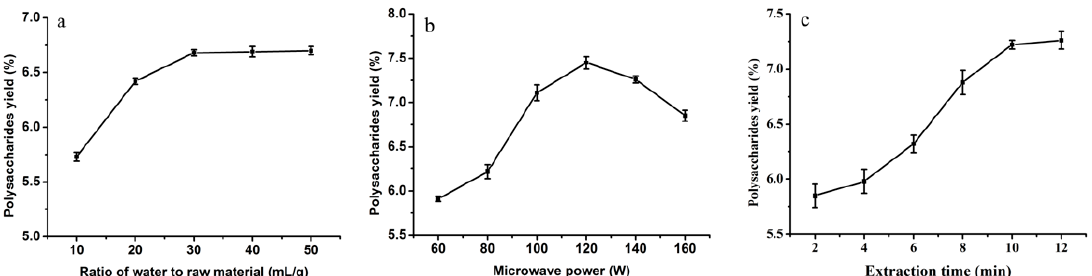
Figure 1. Effects of different extraction parameters (( a ) ratio of water to raw material, mL/g; ( b ) microwave power, W; and ( c ) extraction time, min) on yield of polysaccharides. ( a ) Microwave power and extraction time were fixed at 100 W and 20 min, respectively. ( b ) Ratio of water to raw material and extraction time were fixed at 20 mL/g and 10 min, respectively. ( c ) Ratio of water to raw material and microwave power were fixed at 20 mL/g and 100 W, respectively. Results are represented as mean ± SD ( n = 3).